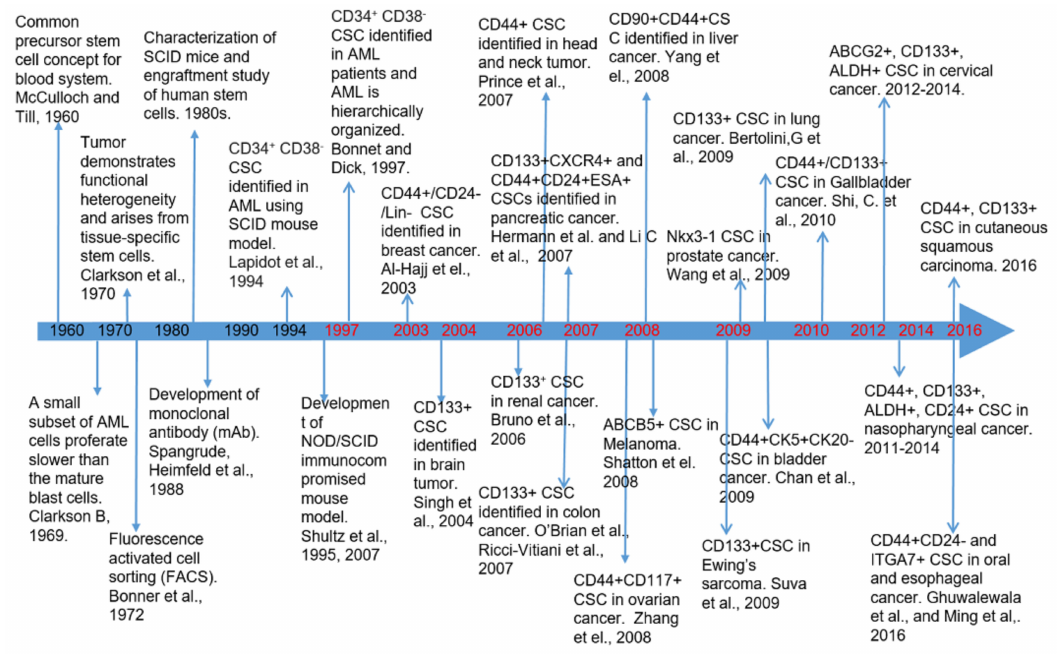
Figure 1. Timeline of the important milestones before cancer stem cells were first identified in AML in 1997 (years marked in black) and CSC identification in di ff erent cancer types (years marked in red) since then to